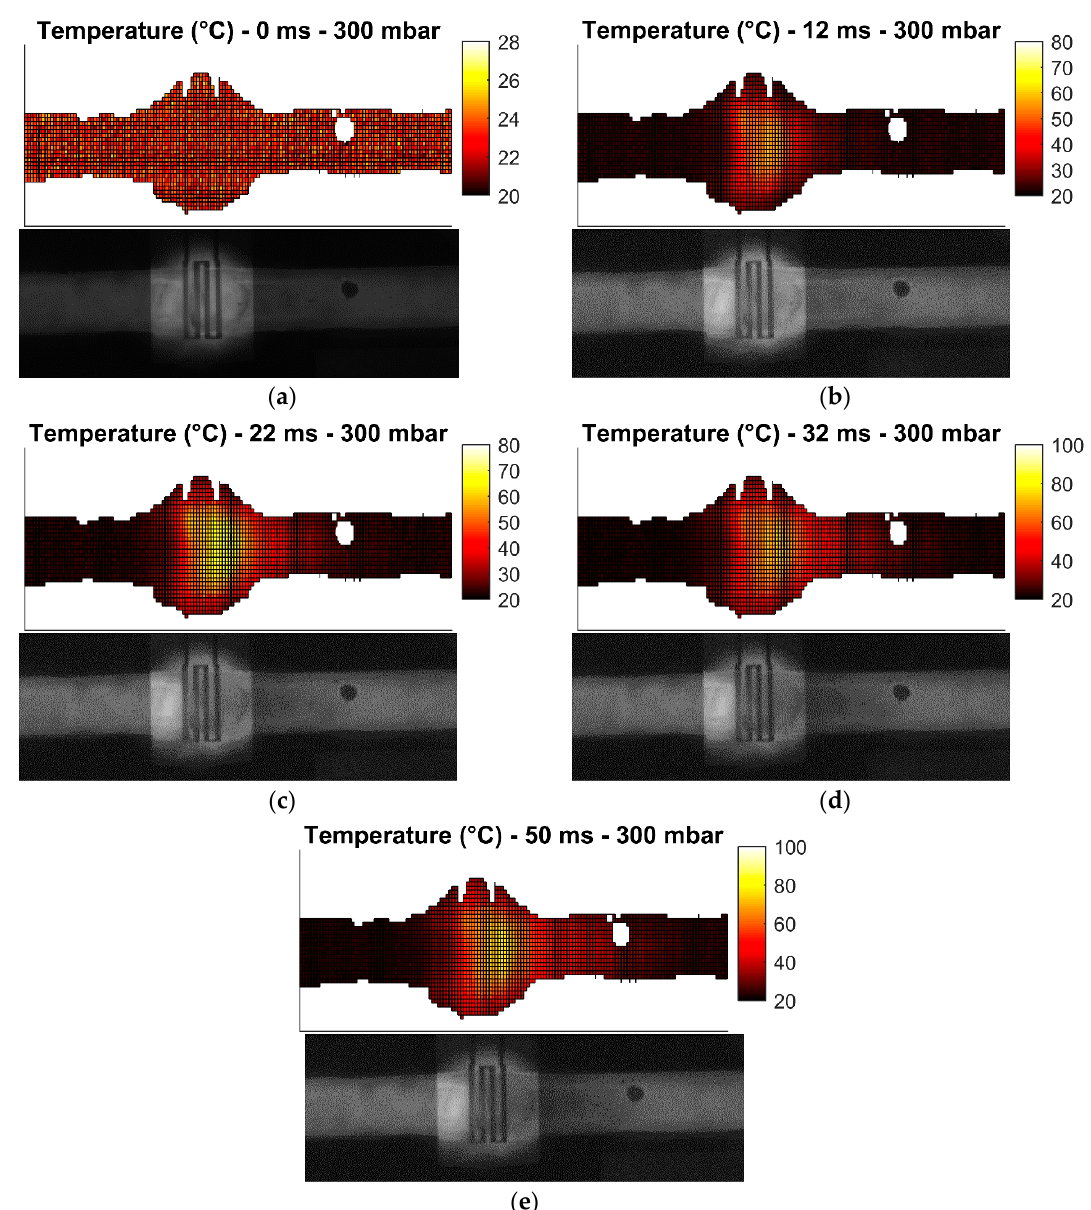
Figure 11. Measured temperature profile (top) of the fluorescent mixture in the channel with the corresponding image (bottom) from the camera for the pressure difference of 200 mbar after: ( a ) prior to heating; ( b ) 12 ms heating started; ( c ) 21 ms heating started; ( d ) 31 ms heating started; ( e ) 66 ms heating started.